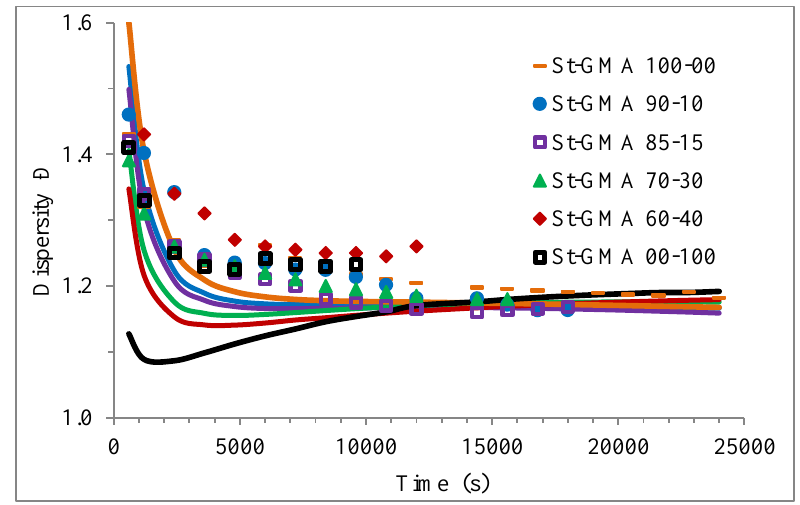
Figure 9. Profiles of dispersity versus time for the different St-GMA samples. Symbols and solid lines correspond to experimental and calculated profiles, respectively.